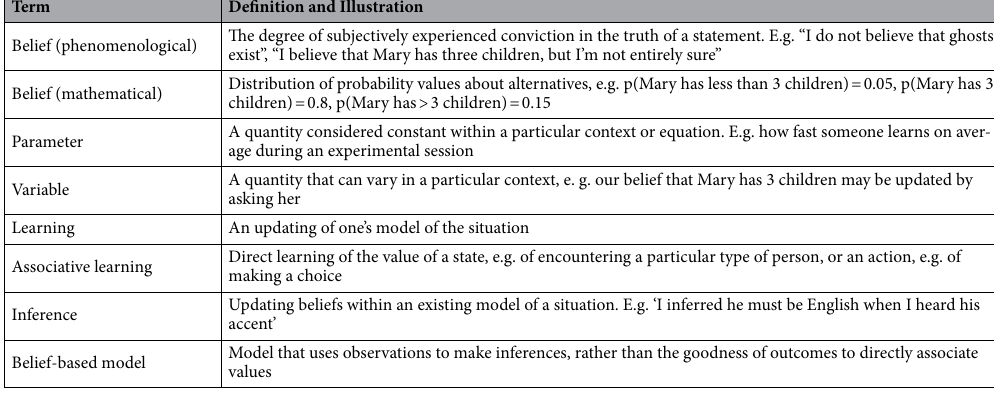
Table 1. Glossary of terms.